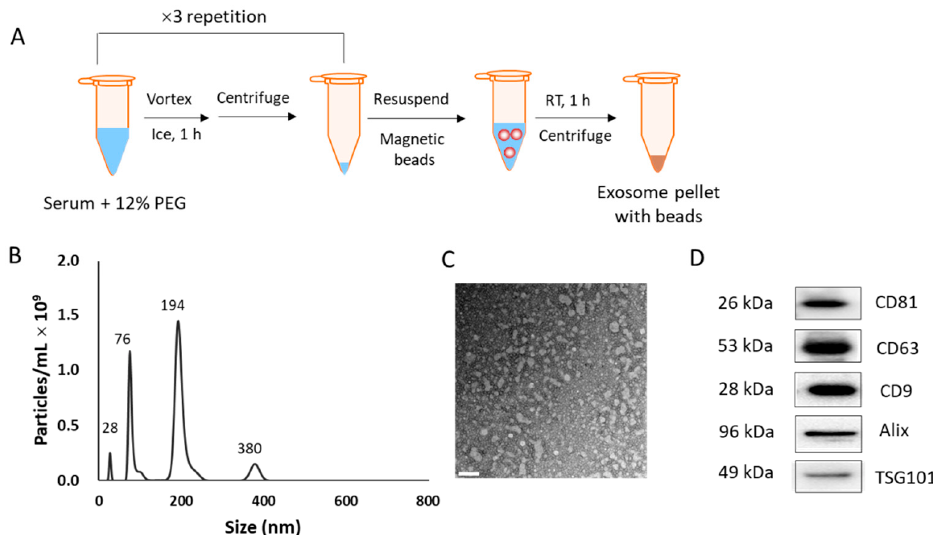
Figure 1. Isolation protocol and characterization of extracellular vesicles (EVs). ( A ) Scheme of the isolation method. ( B ) Nanoparticle tracking analysis of the isolated EVs. ( C ) Transmission electron microscopy image of the isolated EVs. Scale bar = 200 nm. ( D ) Western blotting to check for the presence of EV biomarkers in the EV fraction.